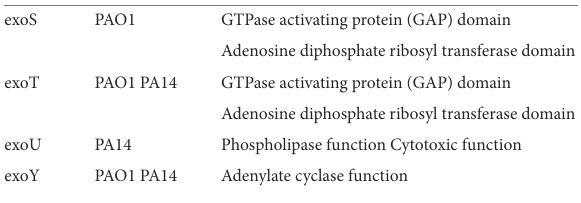
TABLE 1 T3SS effector proteins, associated reference strains, and protein functions (Filloux, 2011; Azimi et al., 2016). Effector PAO1/PA14 Protein